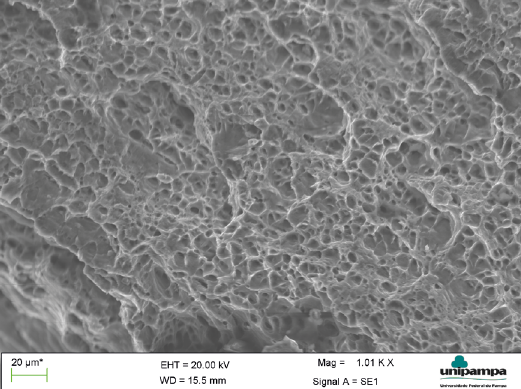
Figure 13. SEM image of the fracture surface showing the presence of equiaxed